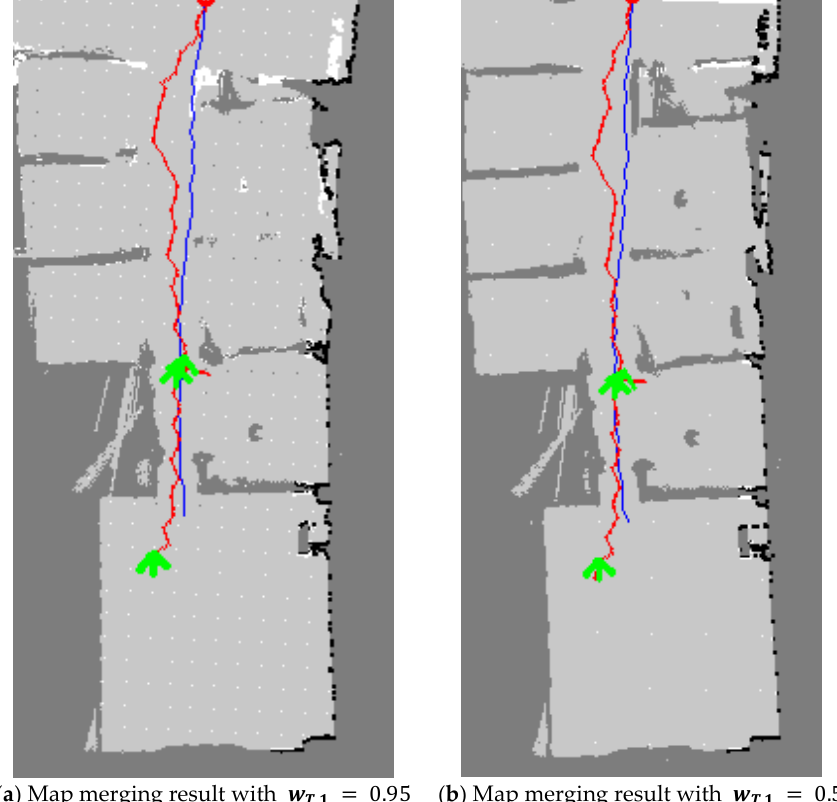
Figure 13. Map merging results with the TSD grid update. By comparing the two maps, a more accurate map was built, as shown in ( b ).